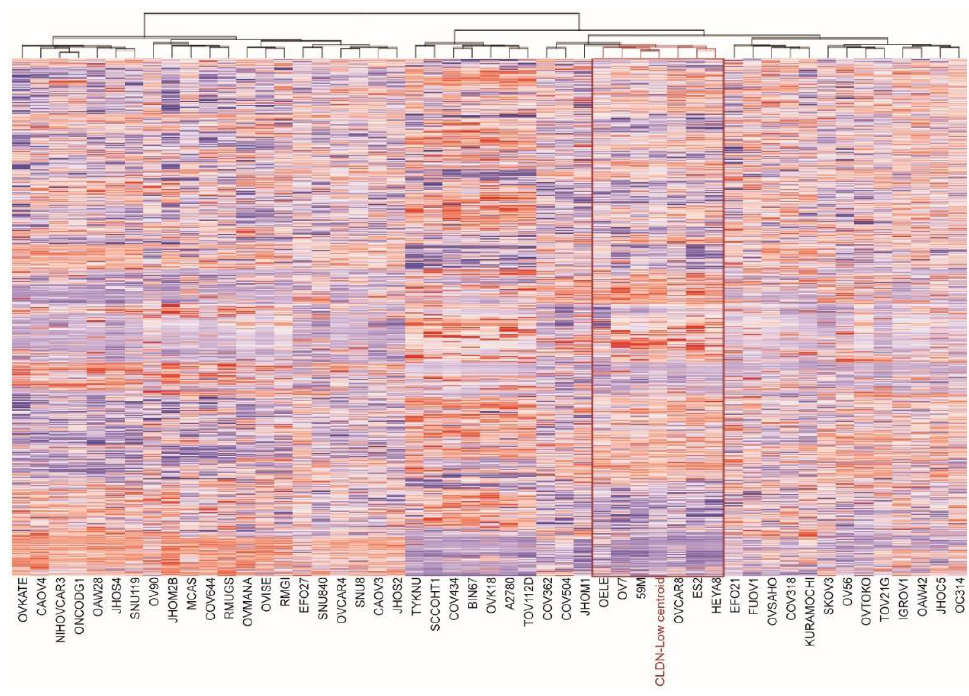
Figure 1. Identification of the claudin-low subtype in CCLE ovarian cancer cell lines. Hierarchical clustering using Euclidean distance metric and Ward algorithm was computed to graphically show the similarity between ovarian cell lines and claudin low (CLDN-low) centroid used for their classification. In the tree, the red node indicates the most highly correlated cell lines displaying similar gene expression patterns as breast claudin-low subtype.